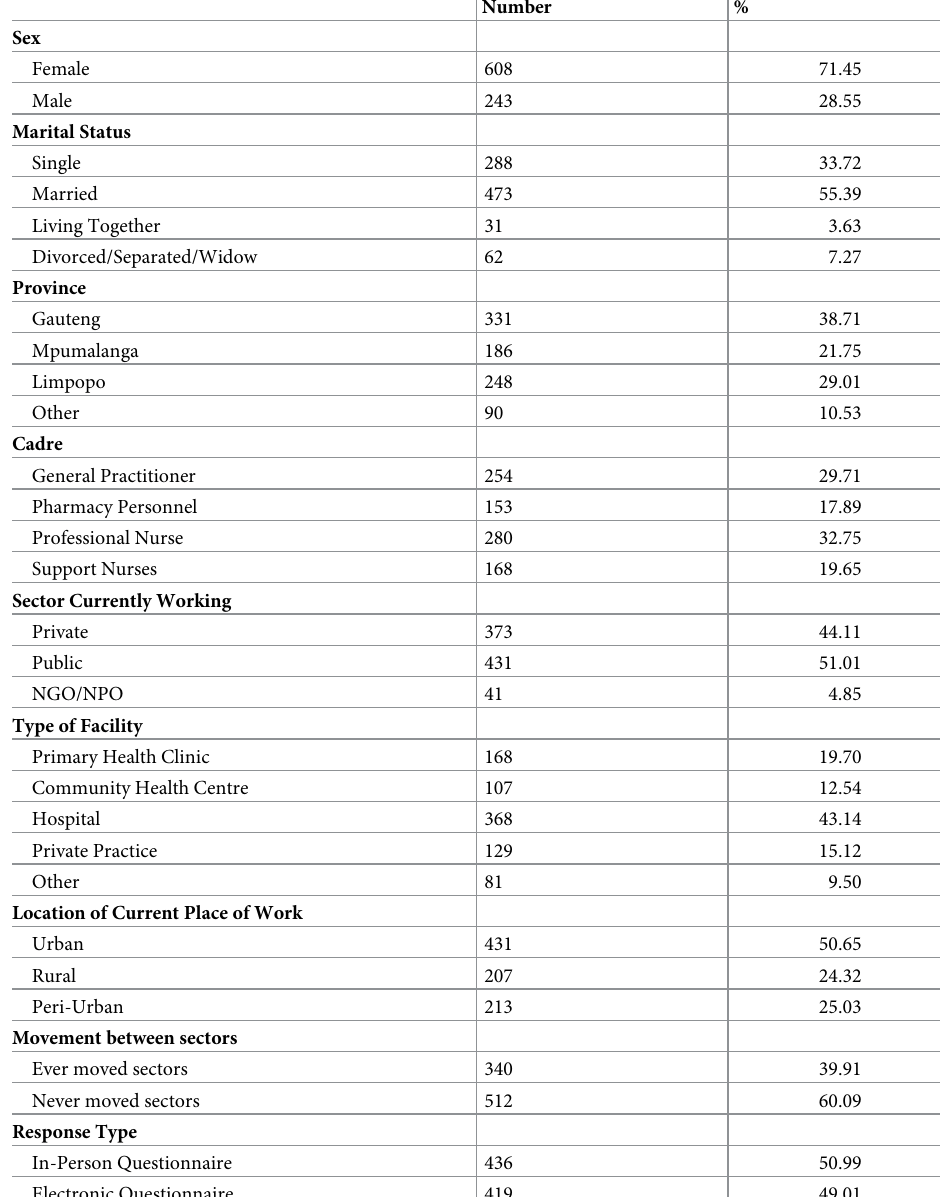
Table 2. Participant socio-demographic and employment